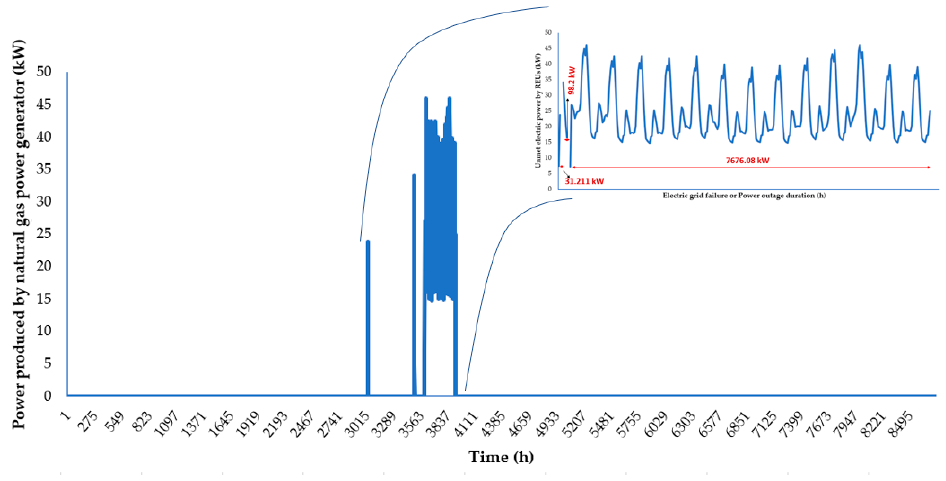
Figure 13. Time series graph showing the operation of the natural gas power generator.